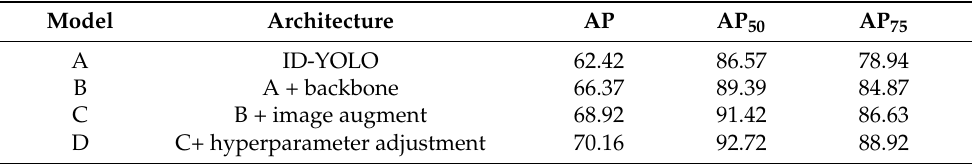
Table 9. The results of the ablation